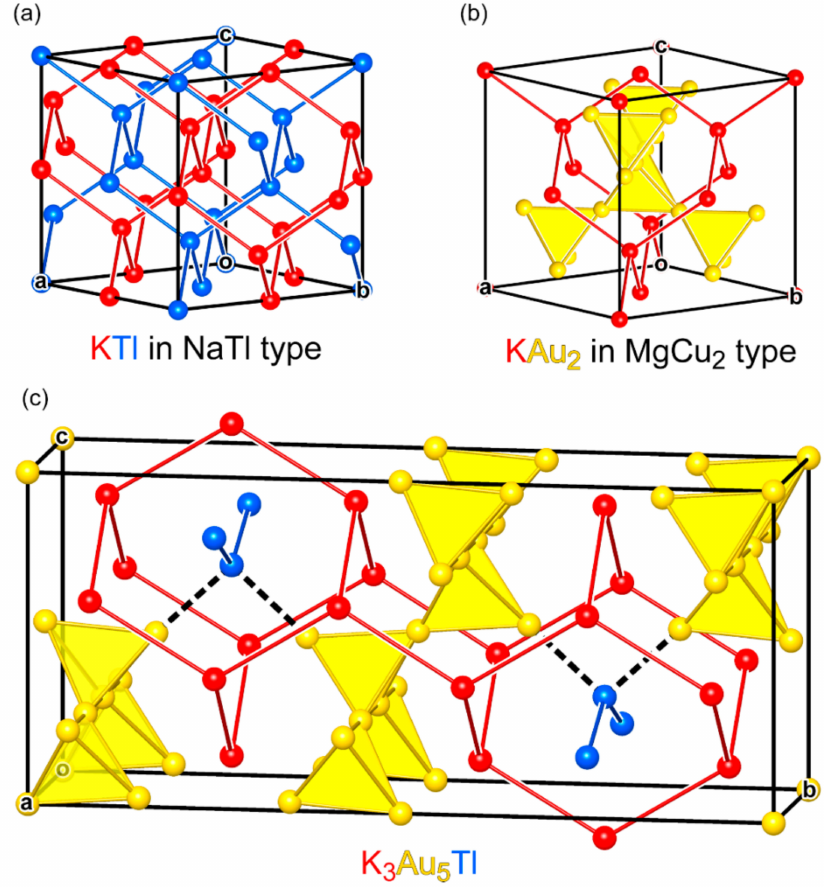
Figure 1. K 3 Au 5 Tl viewed as a Zintl-Laves intergrowth. Crystal structures are shown for ( a ) NaTl- type KTl (hypothetical), ( b ) MgCu 2 -type KAu 2 (hypothetical), and ( c ) K 3 Au 5 Tl, which combines features of the previous